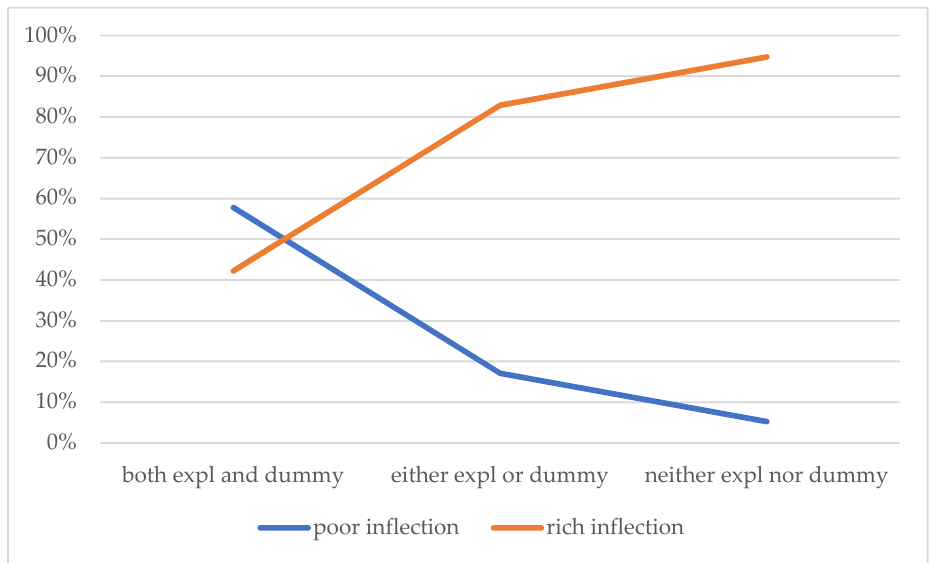
Figure 5. Incidence of dialects with poor and rich inflection in three types of dialects: dialects exhibiting both expletives and dummies; dialects exhibiting either expletives or dummies; and dialects exhibiting neither expletives nor dummies. Source: Manzini and Savoia’s (2005) dataset.